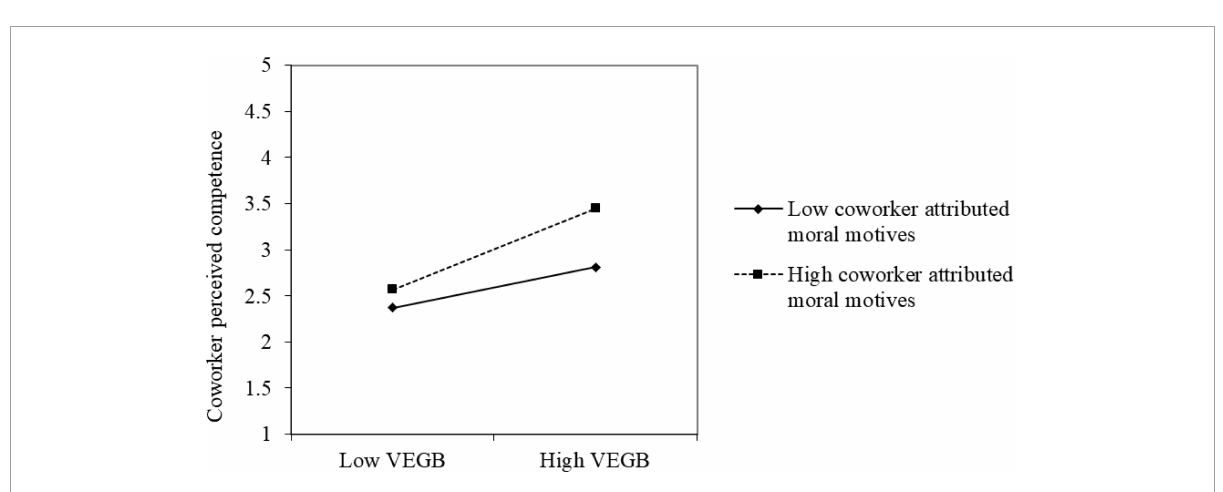
FIGURE5 The interactive effect of VEGB coworker-attributed moral motives on perceived